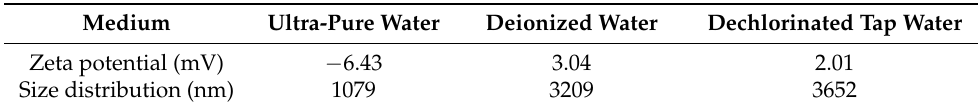
Figure 1. X-ray diffraction image ( A ) and transmission electron microscopy images (scale bar 50 nm) of ZnO NPs dispersed in ultra-pure water ( B ). Table 1. Measured zeta potential and size distribution of ZnO NPs in ultra-pure, deionized, and dechlorinated tap water.